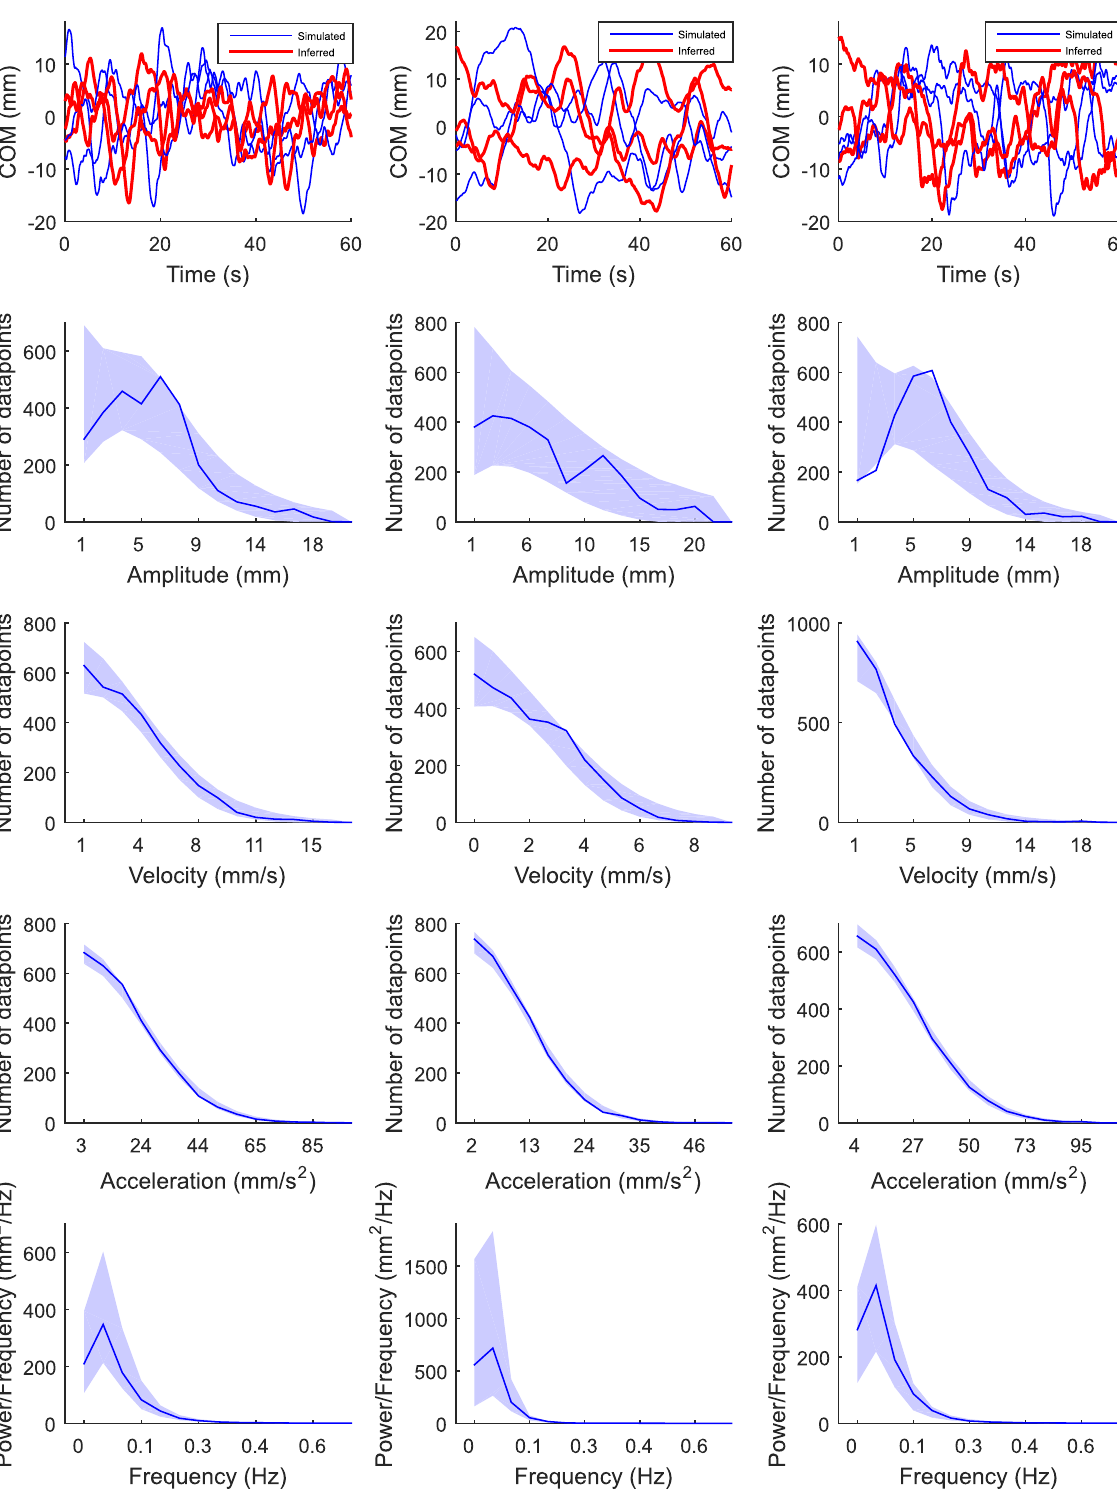
Figure 3. Simulated COM sway signals (top panel) and corresponding summary statistics (four lowest panels). The three columns present three simulated test subjects. The blue COM signals are the original three signals that were simulated with known parameter values. The red COM signals were simulated using parameters that were sampled from the joint posterior PDFs that were inferred from the original COM signals by the SMC- ABC algorithm (see Section Methods: Statistical inference of the model parameters). The lower panels show the summary statistics: amplitude -, velocity -, and acceleration histograms and spectra. In each panel, the blue line is the true summary statistic calculated from the original COM signals (average of the three), and the blue shadowed region presents 95% CIs that were calculated from the COM signals simulated using parameters that were sampled from the inferred marginal posterior PDFs. Leftmost column: true parameters: m = 54